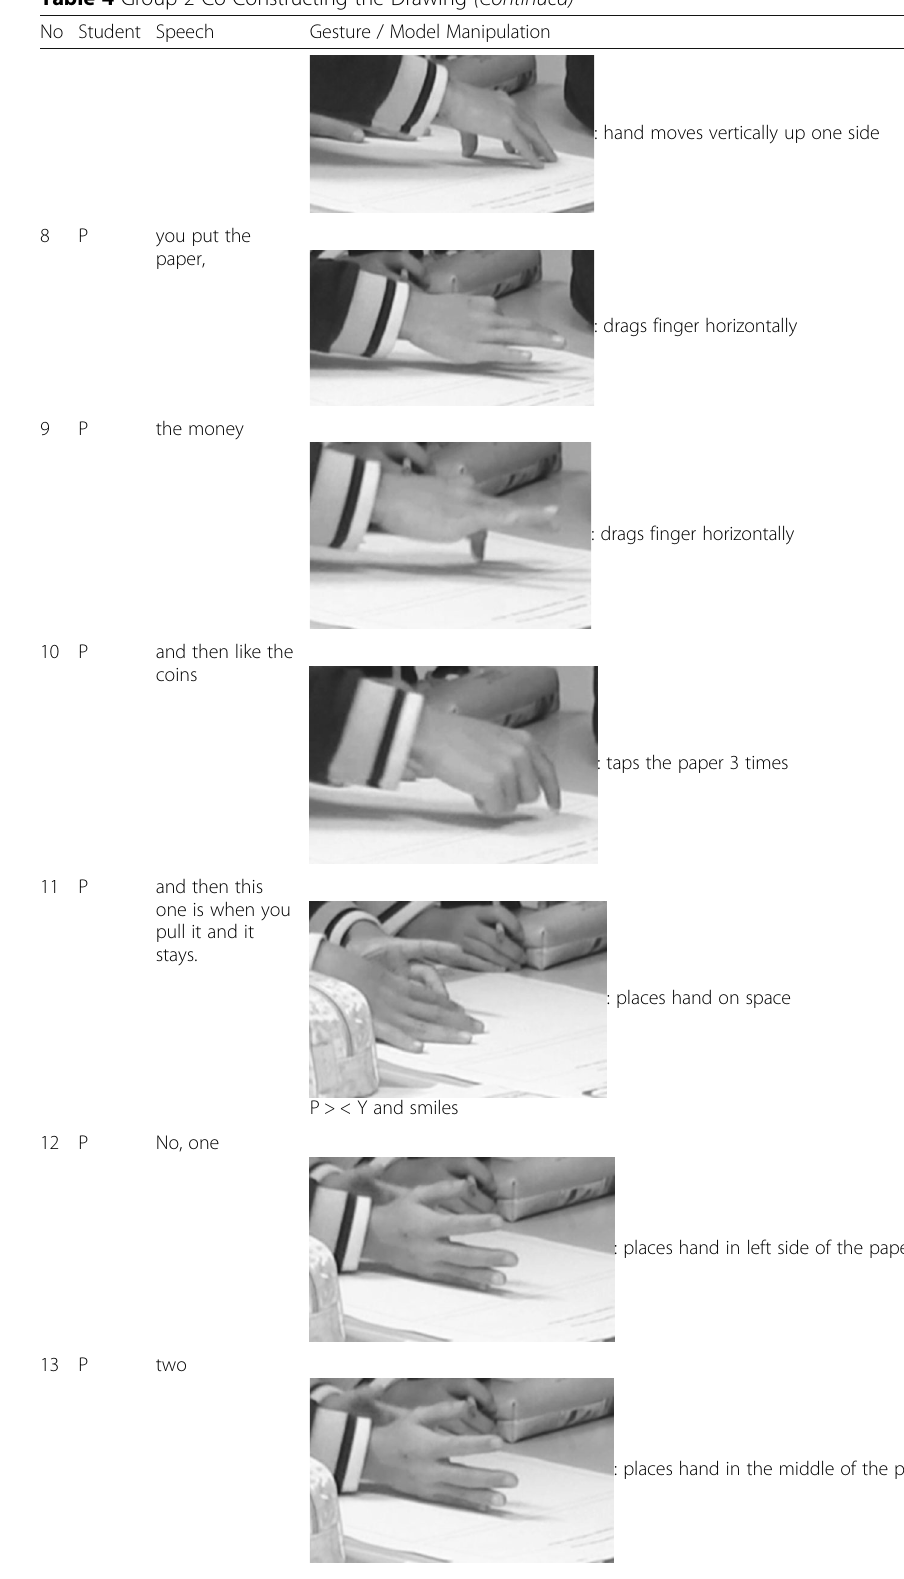
Table 4 Group 2 Co-Constructing the Drawing